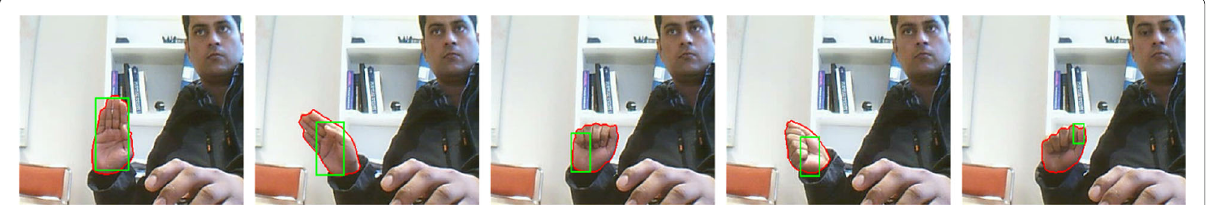
Fig. 4 Tracking results of the proposed method (red) and standard mean shift (green) on hand sequence. #5, 54, 83, 108,